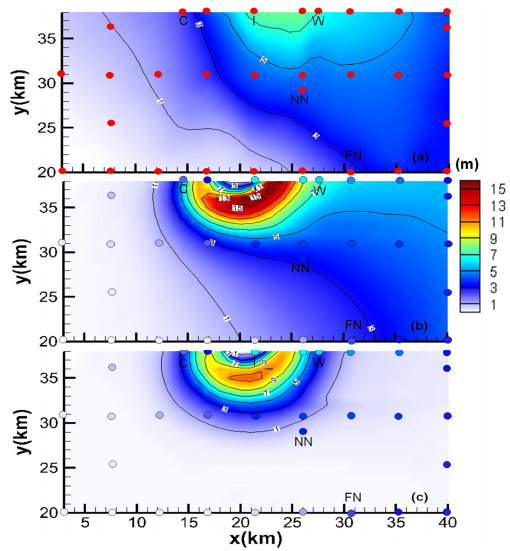
Figure 6. (a) SIPL thickness over a green box in Fig. 1, interpo- lated using a natural-neighbour method, from drill-hole measure- ments (red dots). (b, c) SIPL thickness derived from (b) VM and (c) VU models, compared with drill-hole measurements (colour- coded dots). Note that the colour scale is